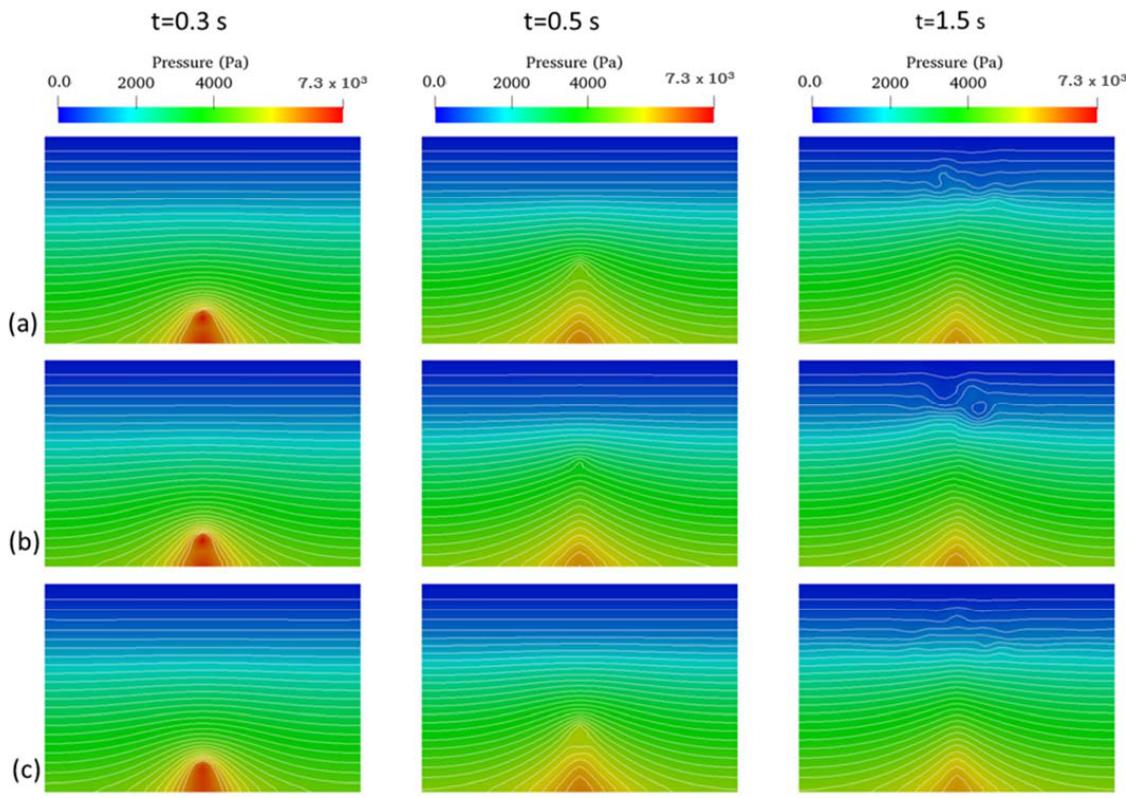
Figure 11. Water pressure distribution over the sand bed at times 0.3, 0.5, and 1.5 s for particle distributions ( a ) PSD1, ( b ) PSD2, and ( c ) PSD3.